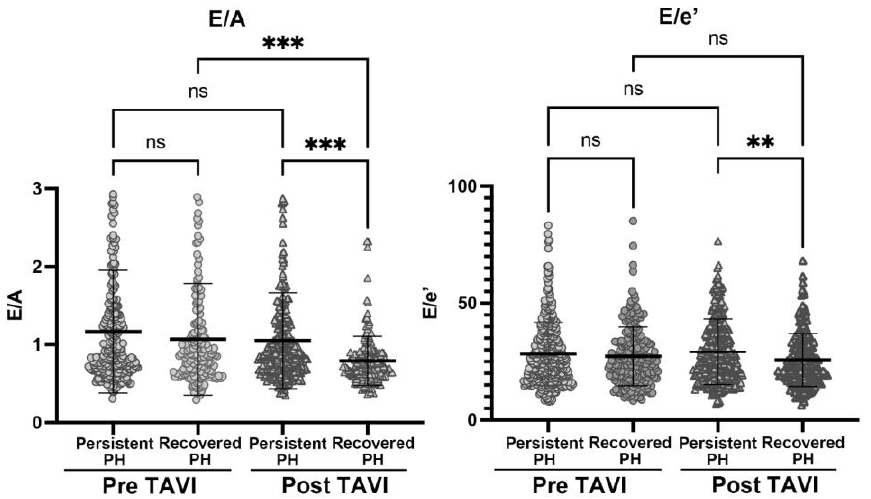
Figure 3. Changes in E/A and E/e’ ratios through TAVI in patients with PH. Figure legend: Pre- and post-TAVI E/A ( left ) and E/e’ ( right ) ratios in Persistent and Recovered PH groups. Com parisons using one way ANOVA calculated the significance in each group and timing of the measurement. *: p < 0.05, **: p < 0.01 and ***: p < 0.001.